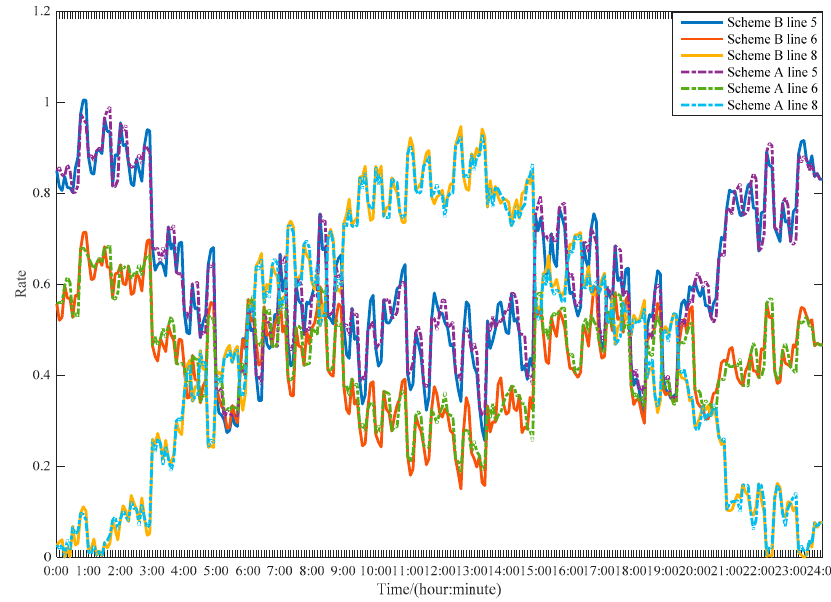
Figure 8. Load ratio (line apparent power flow over rated capacity) of nine transmission lines in scheme A and B.